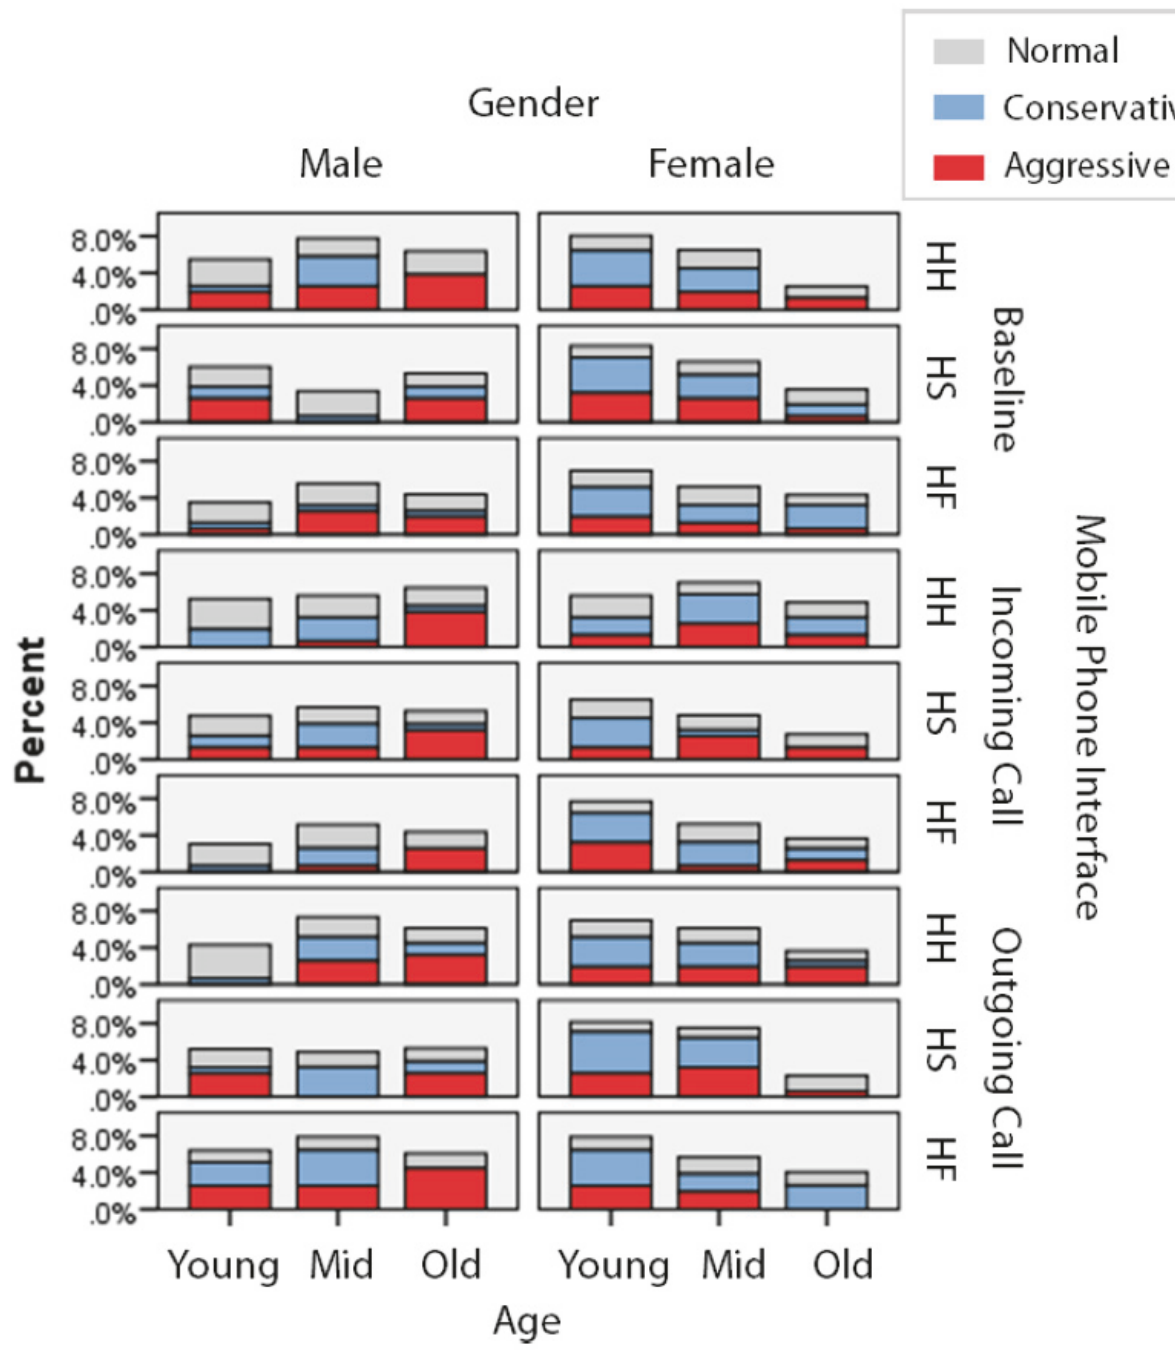
Figure 1: Sensitivity of driver classification to aggressiveness